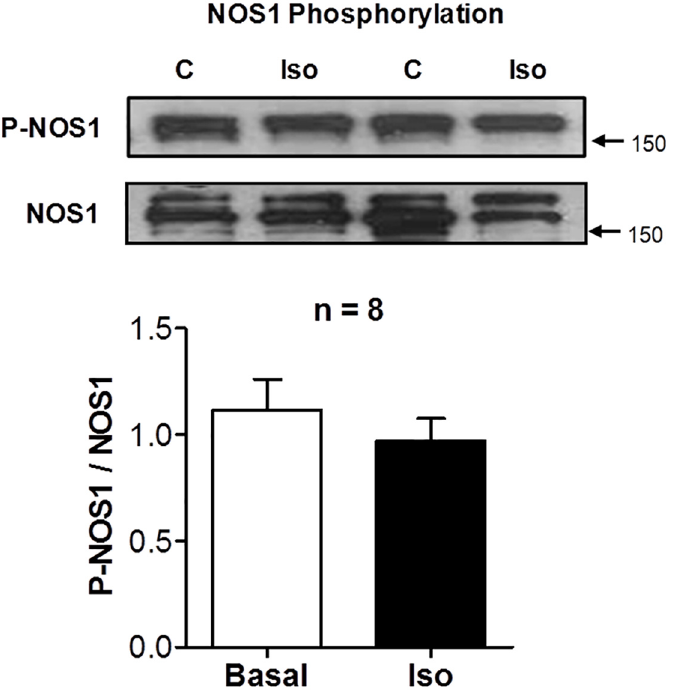
Fig 6. Isoproterenol does not modify NOS-1 phosphorylation. Representative Western blot of NOS-1 phosphorylated at Ser1412, and corresponding total NOS-1 content in hearts homogenized before (control, C) and after stimulation with isoproterenol (10nM, 3-min, Iso). The graph shows densitometric analysis of the phospho-NOS-1 over total NOS-1 content ratio (n = 8). No differences were